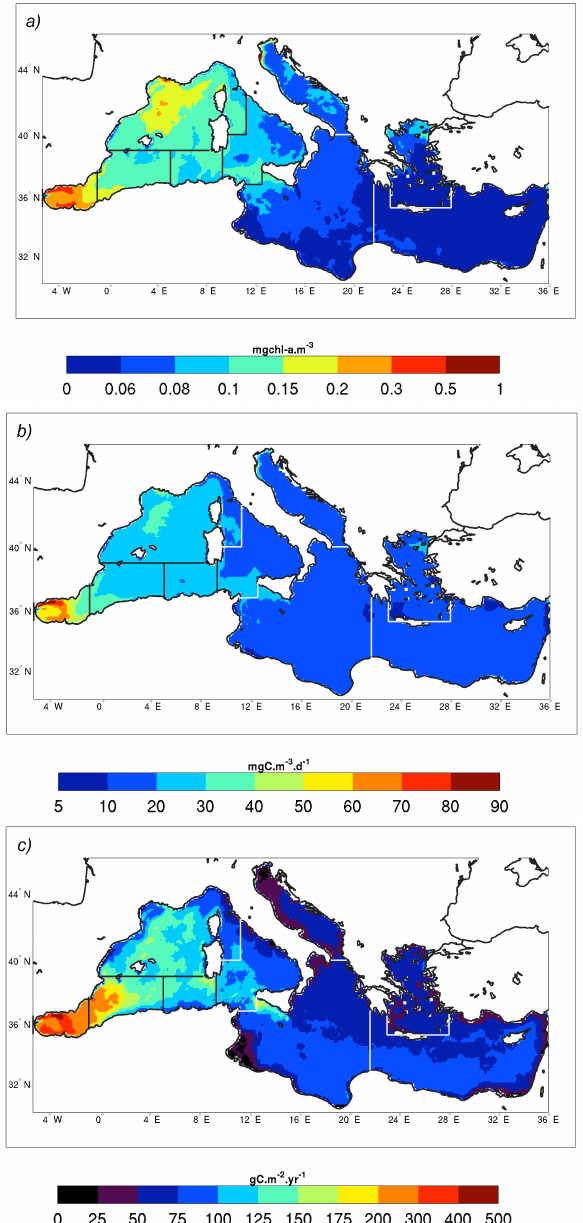
Fig. 8. Model-derived climatology of (a) annual surface chlorophyll concentration (mgchl- a m − 3 ); (b) surface net primary production (mgCm − 3 d − 1 ); (c) vertically integrated net primary production (gCm − 2 yr − 1